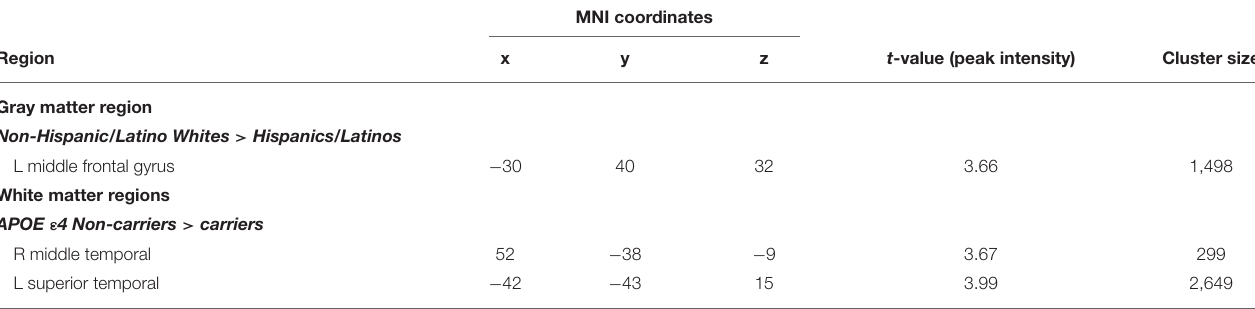
TABLE 5 | Regions in which group (ethnicity or APOE ε 4 status) differences in volumes were detected, p < 0.001, k ≥ 50, controlling for age and intracranial volume.